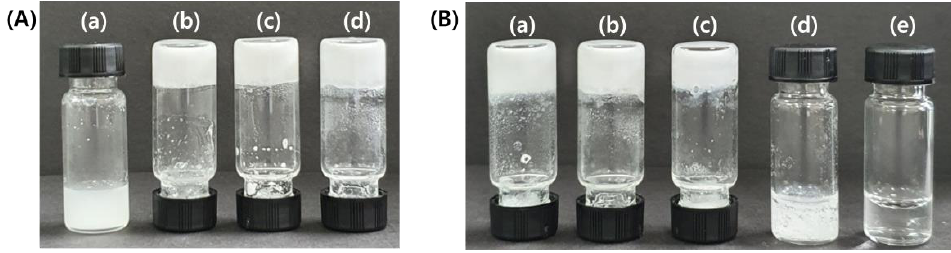
Figure 2. ( A ) Photographs of the gels prepared from gelator 1 (a) 2 mg, (b) 4 mg (c) 6 mg (d) 8 mg in ACN (0.2 mL). ( B ) 8 mg of gelator 1 and (a) 0.1 equiv., (b) 0.3 equiv., (c) 0.5 equiv., (d) 0.7 equiv., (e) 0.9 equiv. of Zn 2+ in ACN (0.2